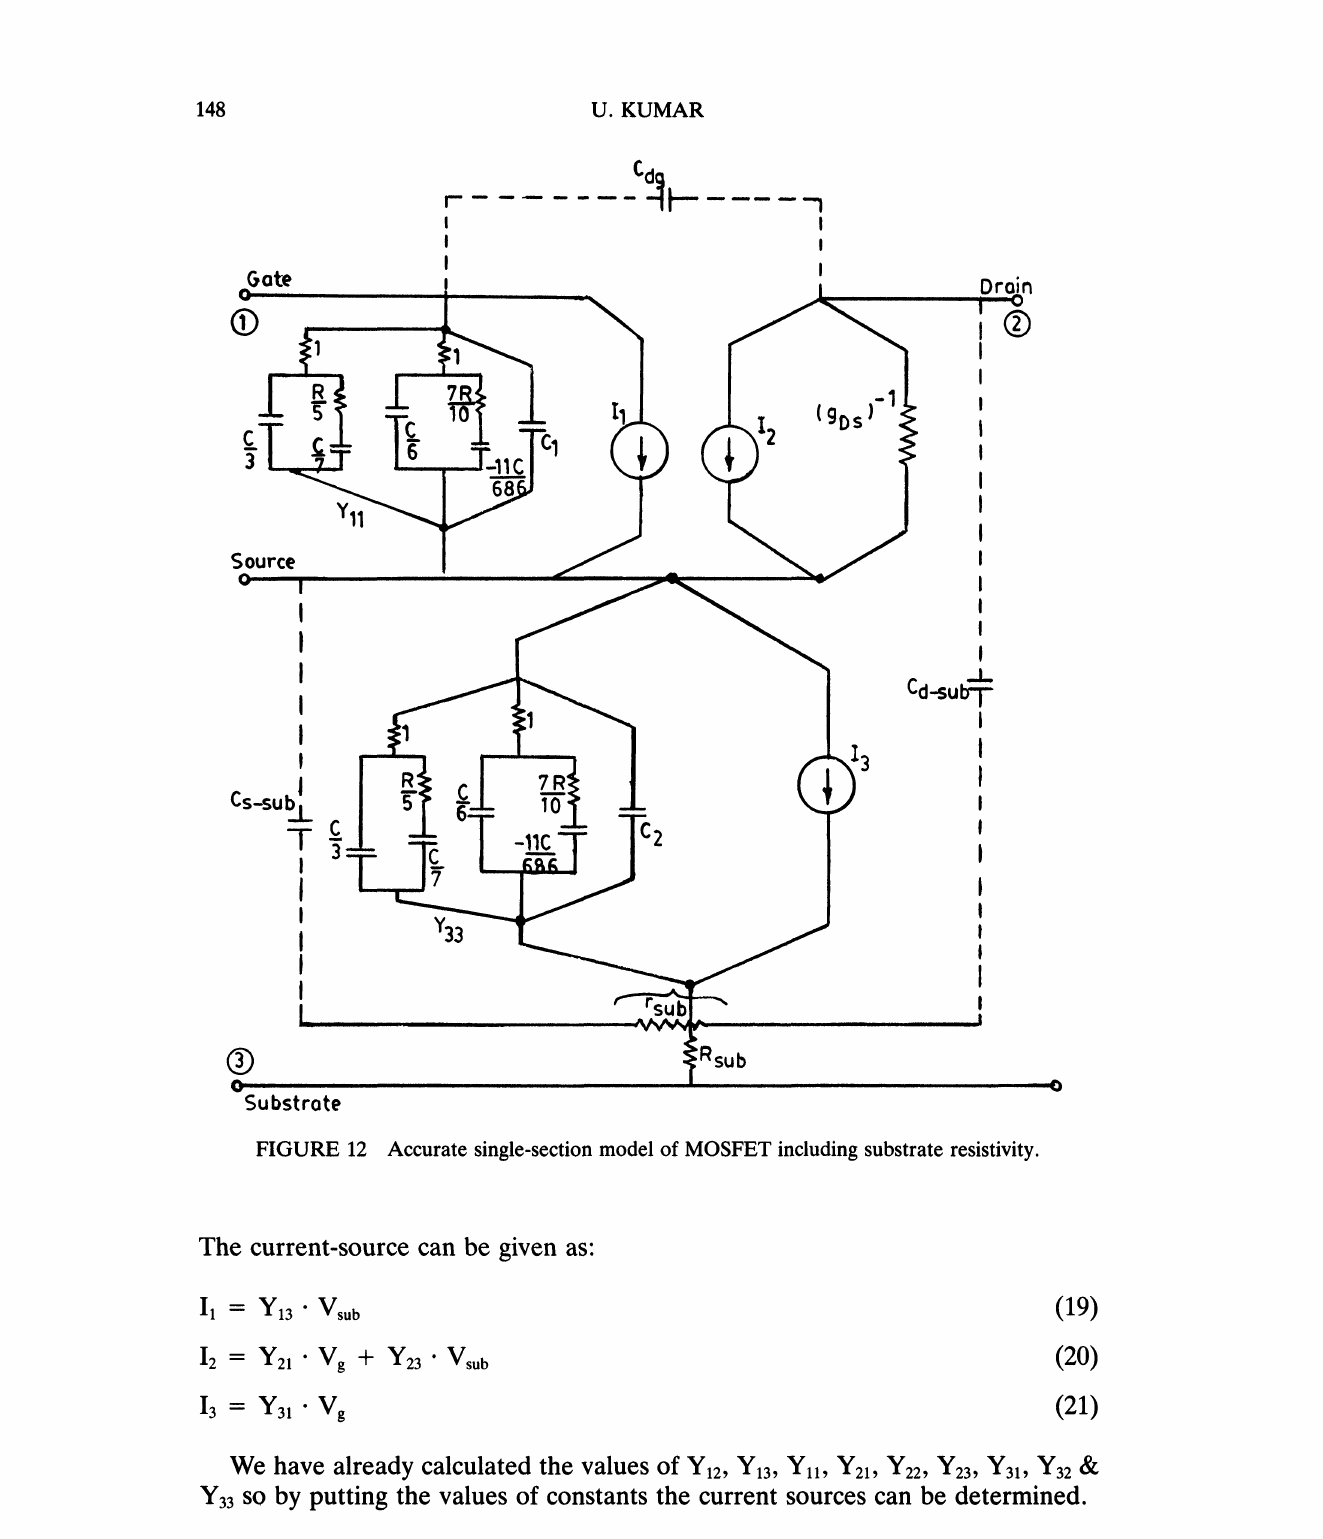
FIGURE 12 Accurate single-section model of MOSFET including substrate